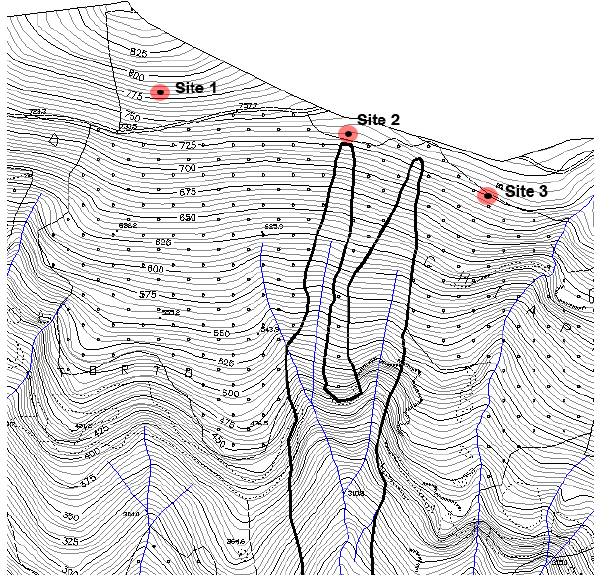
Figure 2. Topographic map and sites where suction measurements were performed.